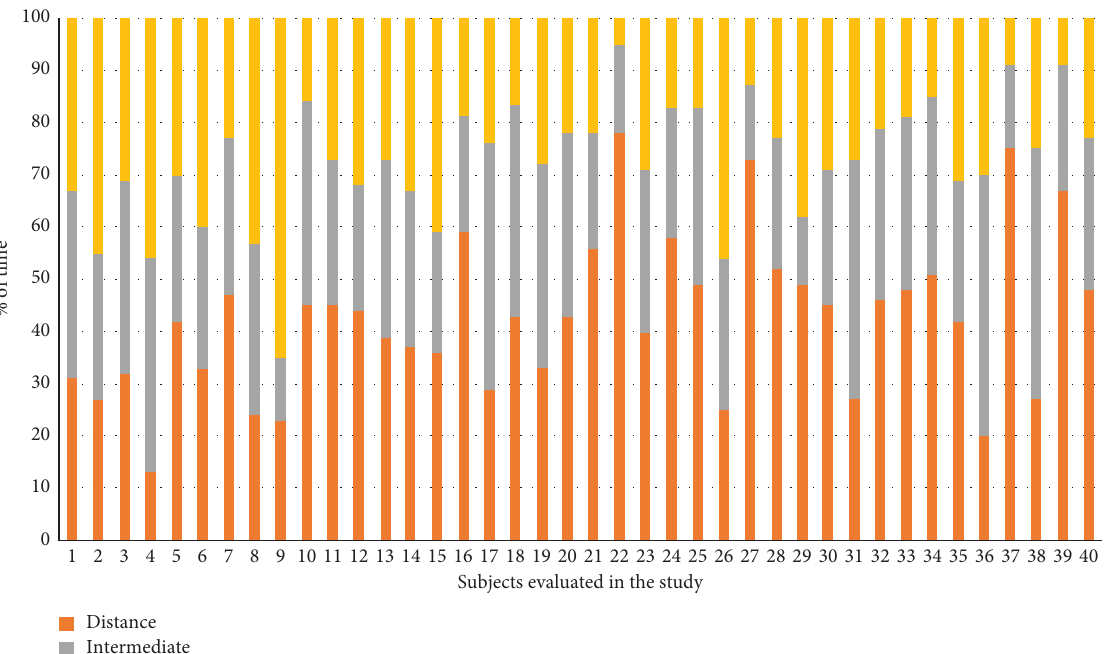
Figure 2: Distribution per patient of the time dedicated to distance, intermediate, and near visual activities measured in the evaluated sample.